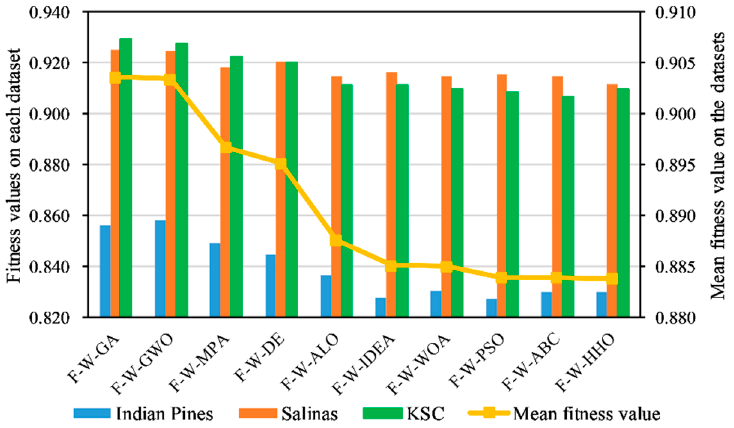
Figure 5. The fitness values of the F–W–SIEAs on the different datasets. The bar chart shows the fitness of each on the different datasets, and the line chart shows the mean fitness value.